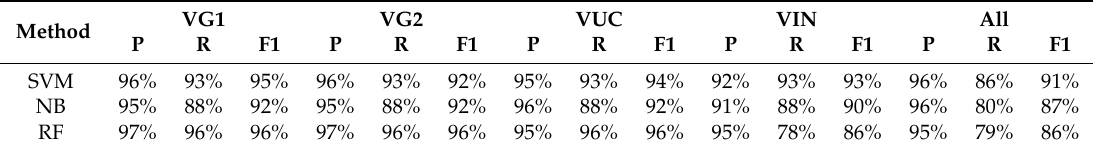
Table 12. Performance of different algorithms, when classifying out-of-domain interactions against question variations of different types.